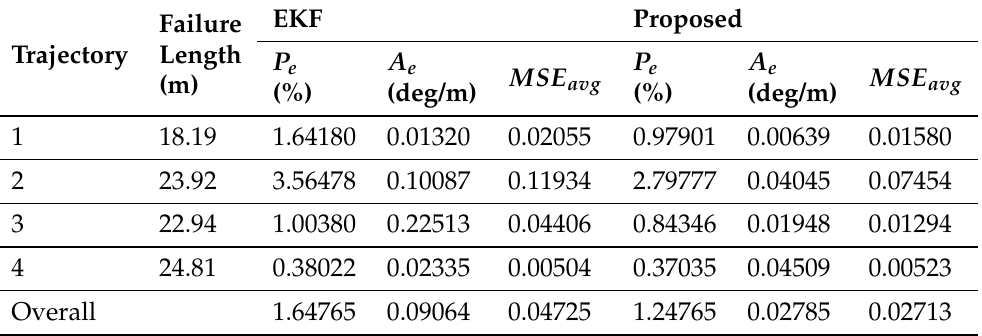
Figure 6. Estimated path comparison results for trajectory 4. Green, orange, and blue lines represent EKF, EKF+CNN with MHA, and ground truths, respectively. Table 1. Results for the four trajectory paths followed by evaluation metrics. Failure length: moving track length of robot during SLAM failure period; P e : position error; A e : rotation error; MSE avg : average mean squared